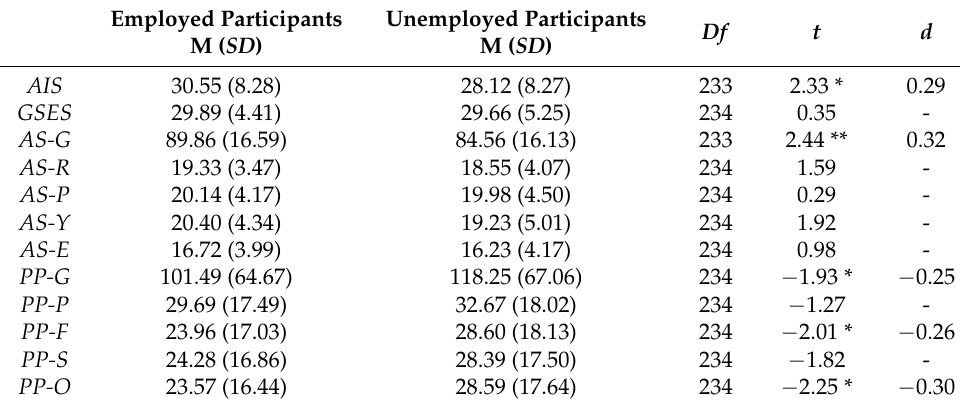
Table 1. Values of the investigated variables by subgroup.